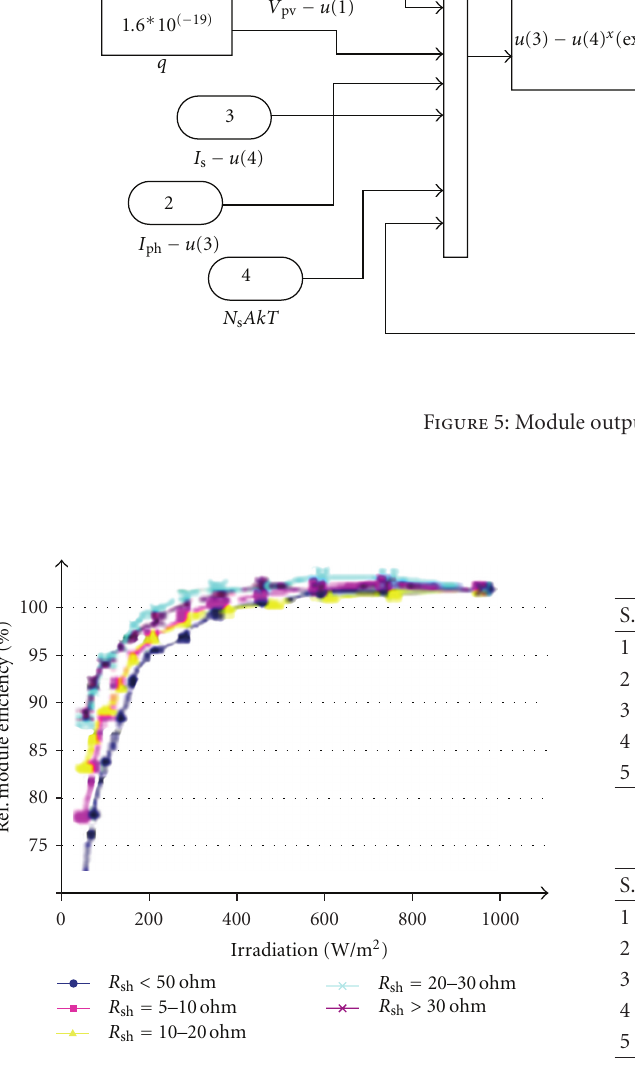
Figure 6: Relative e ffi ciency versus irradiation. Table 2: Electrical characteristic data of solkar 36 W PV module.